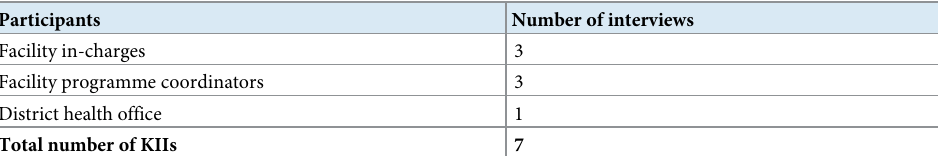
Table 2. Key informant interviews.